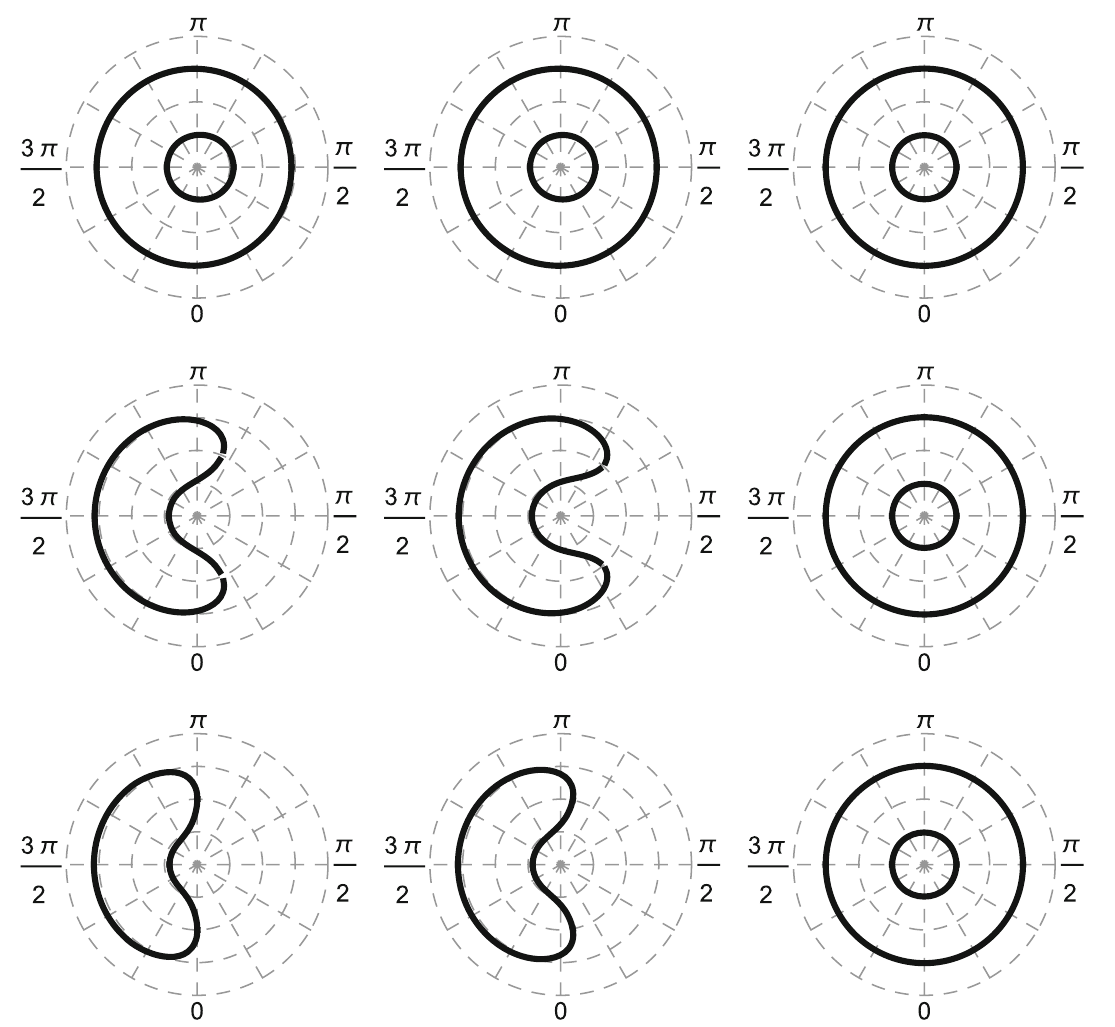
Fig. 11 Escape cones for objects with compactness R / M = 2 . 4 for several values of θ and j . The first column is for θ = π/ 2, the second column is for θ = π/ 4 and the last column is for θ = 1 / 100. The first row is for j = 0 . 1, the second row is for j = 0 . 4 and the last row is for j = 0 .